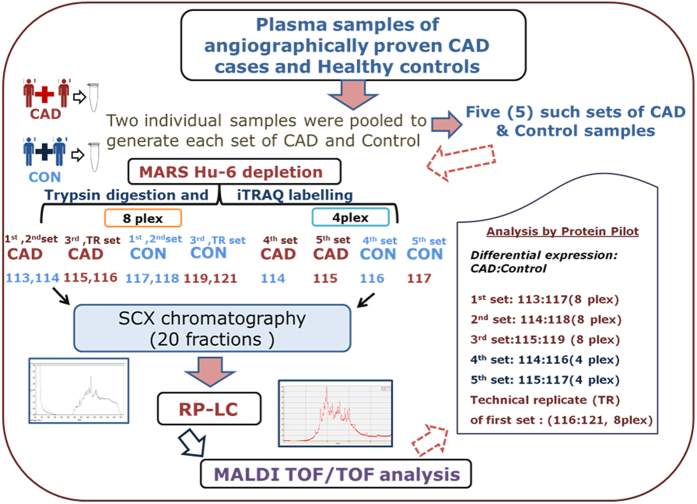
Schematic workflow for the iTRAQ based discovery phase analysis.